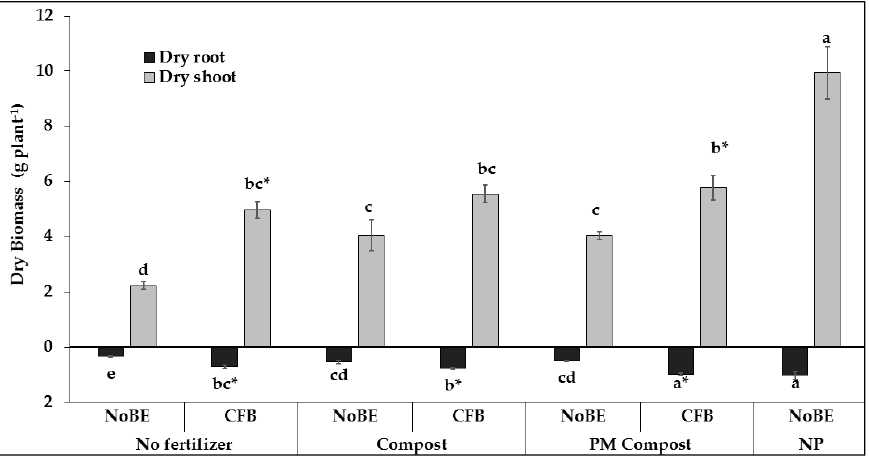
Figure 2. Shoot and root dry weight of 7-week-old tomatoes on pH 7.8 soil (CFB = Combifector B, PM = poultry manure, NP = calcium nitrate plus superphosphate. Means and SE of five replicates. Significant treatment differences are indicated by different letters (T-grouping (LSD) at p = 0.05). * = significant difference compared with the non-inoculated control (NoBE) within the same fertilizer treatment ( t -test at p < 0.05).